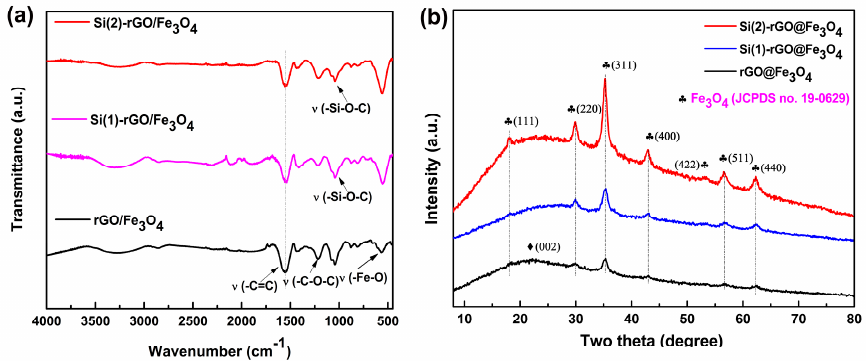
Figure 2. FT-IR spectra ( a ) and XRD patterns ( b ) of Si-modified rGO@Fe 3 O 4 nanocomposites.